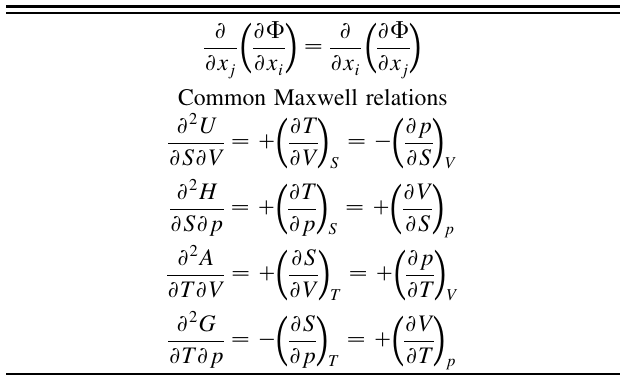
TABLE VIII. Maxwell